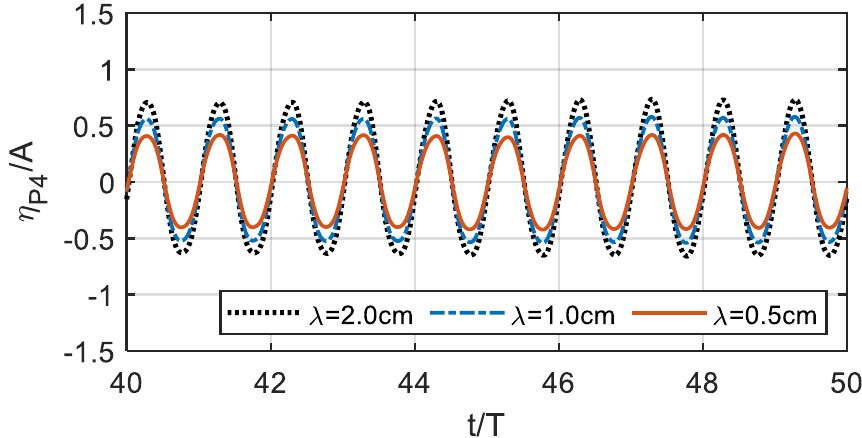
Figure 11. Variations in the wave elevation at gauge P4 for the platform with various fishnet mesh